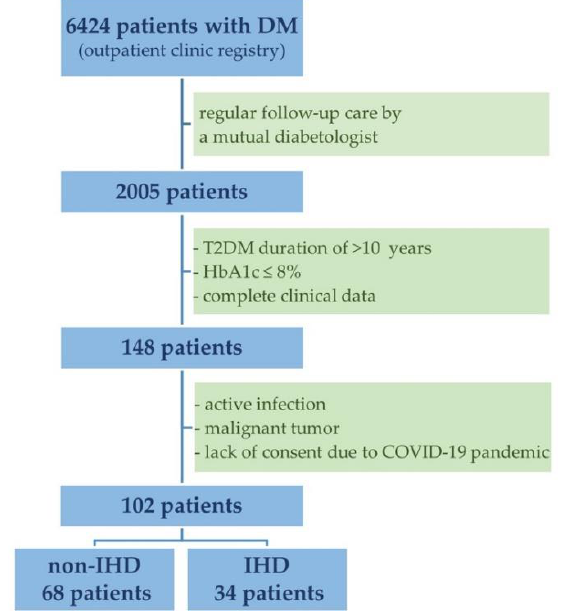
Figure 1. Flow chart for patient enrollment. Abbreviations: DM, diabetes mellitus; T2DM, type 2 diabetes mellitus; HbA1c, hemoglobin A1c; COVID-19, coronavirus disease 2019; IHD, ischemic heart disease.